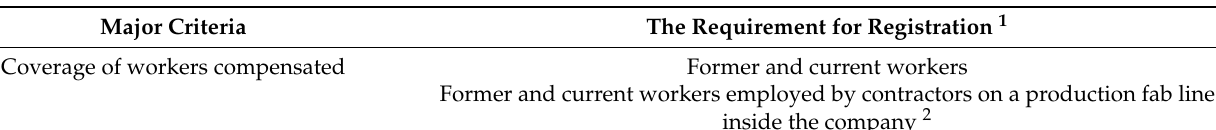
Table 4. The requirements for semiconductor workers who may register with the financial support compensation (FSC)